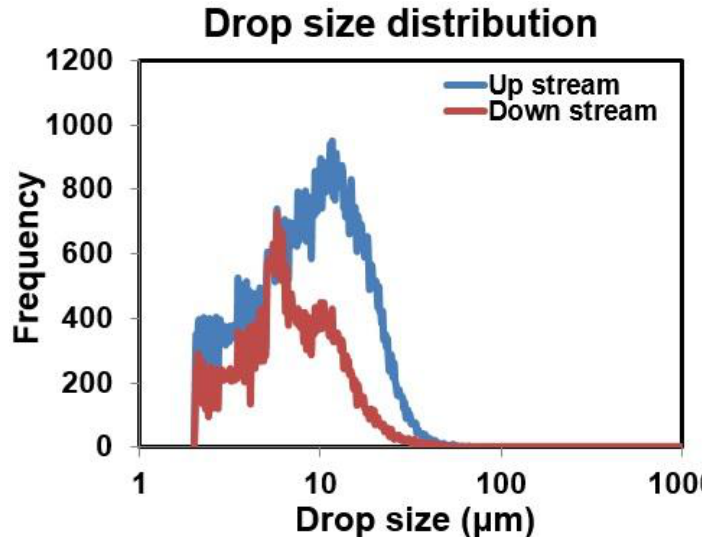
Figure 10. Water droplet diameter distribution from upstream and downstream samples of beaded fibers.